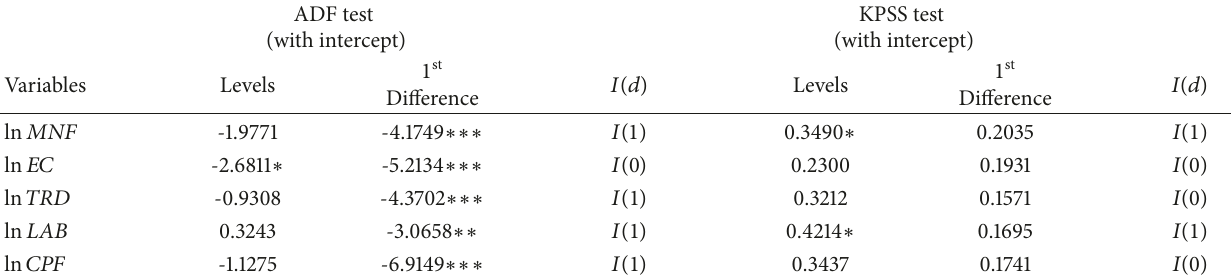
Table 2: Tests for unit root in